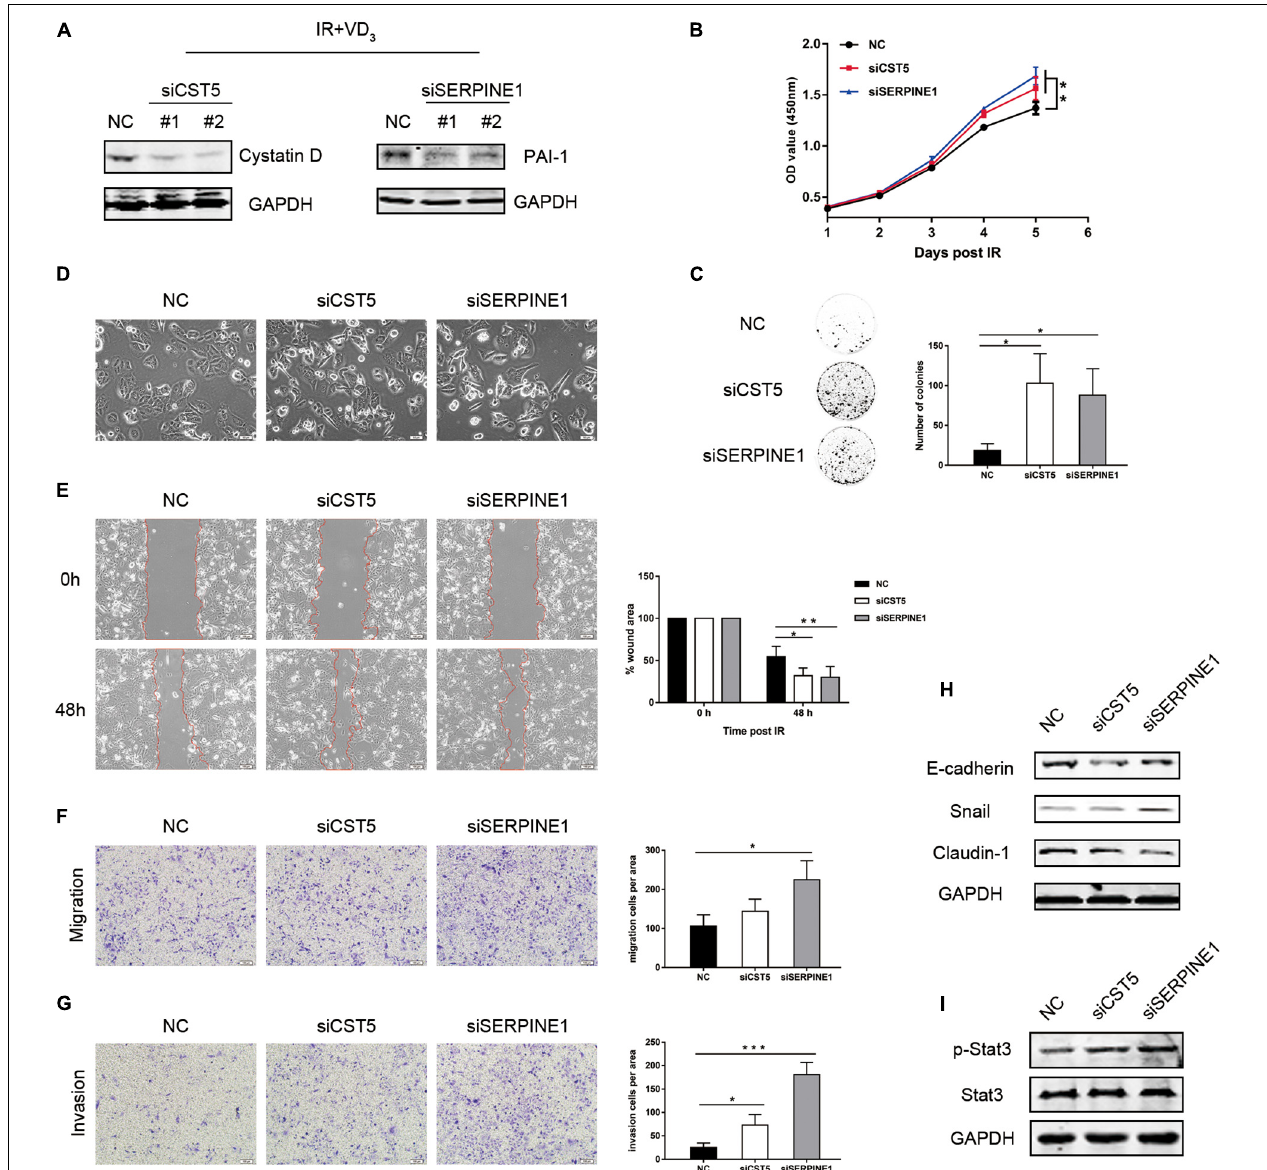
FIGURE 5 | Gene inhibition partially reversed sensitivity to IR by regulating EMT. (A) SW480 cells transfected with the indicated small interfering RNAs (siRNAs) were treated with the combination treatment (IR + VD 3 ) and analyzed by western blot. (B) siRNAs of CST5 and SERPINE1 promoted cell viability, which was recorded everyday using CCK8. (C) CST5 and SERPINE1 loss enhanced colony formation. Colonies were detected after incubating for 14 days. (D) Morphological changes following siRNAs treatment. (E) Cell migration rate was compared by the wound-healing assay. Observations were recorded at 0 and 48 h after scratching the cell layer. Scale bar: 100 µ m. (F,G) Transwell assay detected the effect of siRNAs on cellular migration and invasion. Scale bar: 100 µ m. (H) Expression of EMT markers were examined by western blot. (I) Expression of JAK/STAT3 signaling proteins were examined by western blot. *p < 0.05, **p < 0.01, ***p <